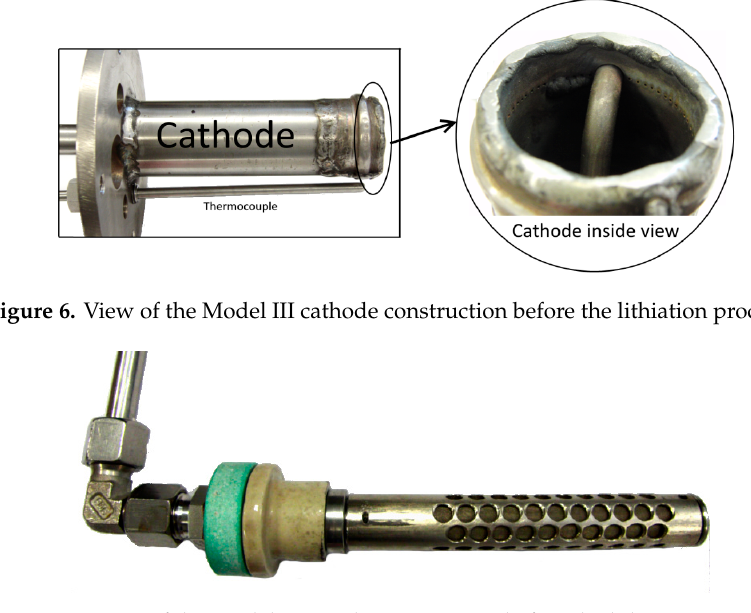
Figure 7. View of the Model III anode construction before the lithiation process.